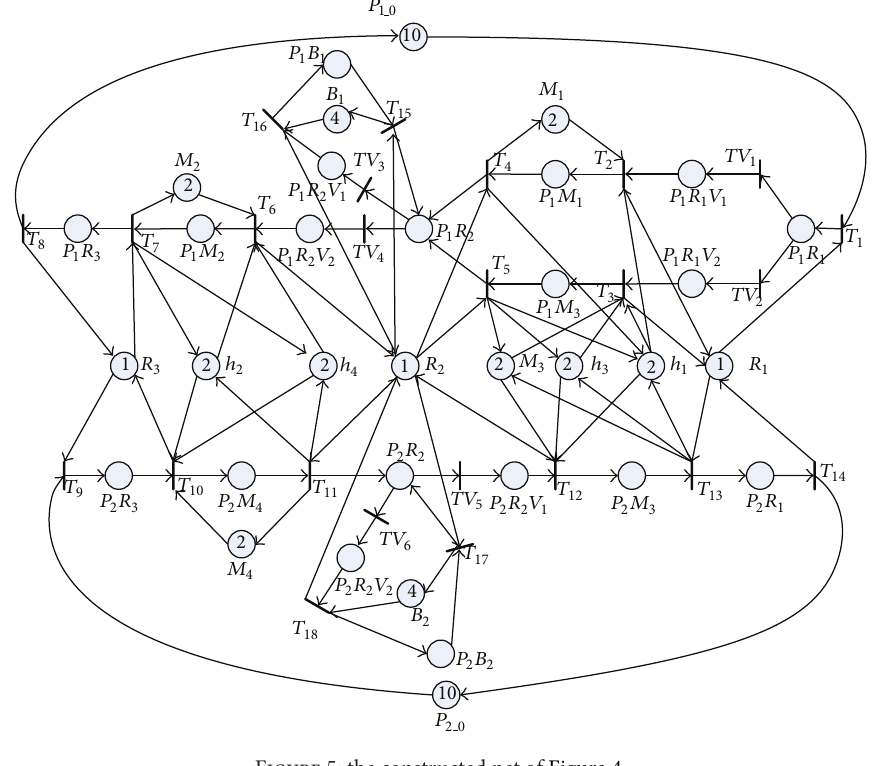
Figure 5: the constructed net of Figure 4.